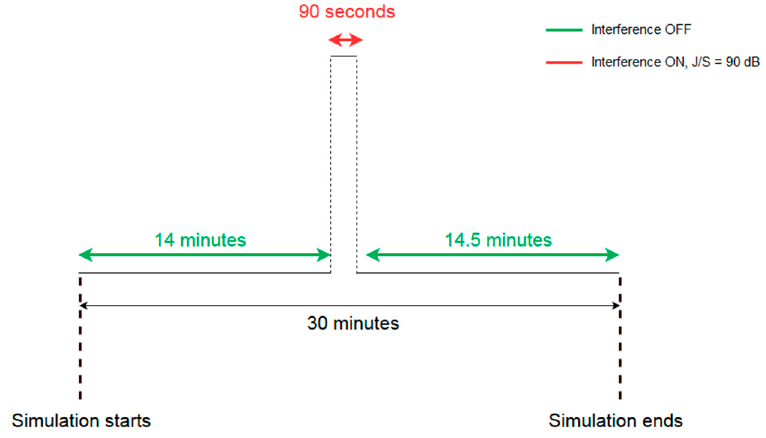
Figure 2. TTRP test profile.